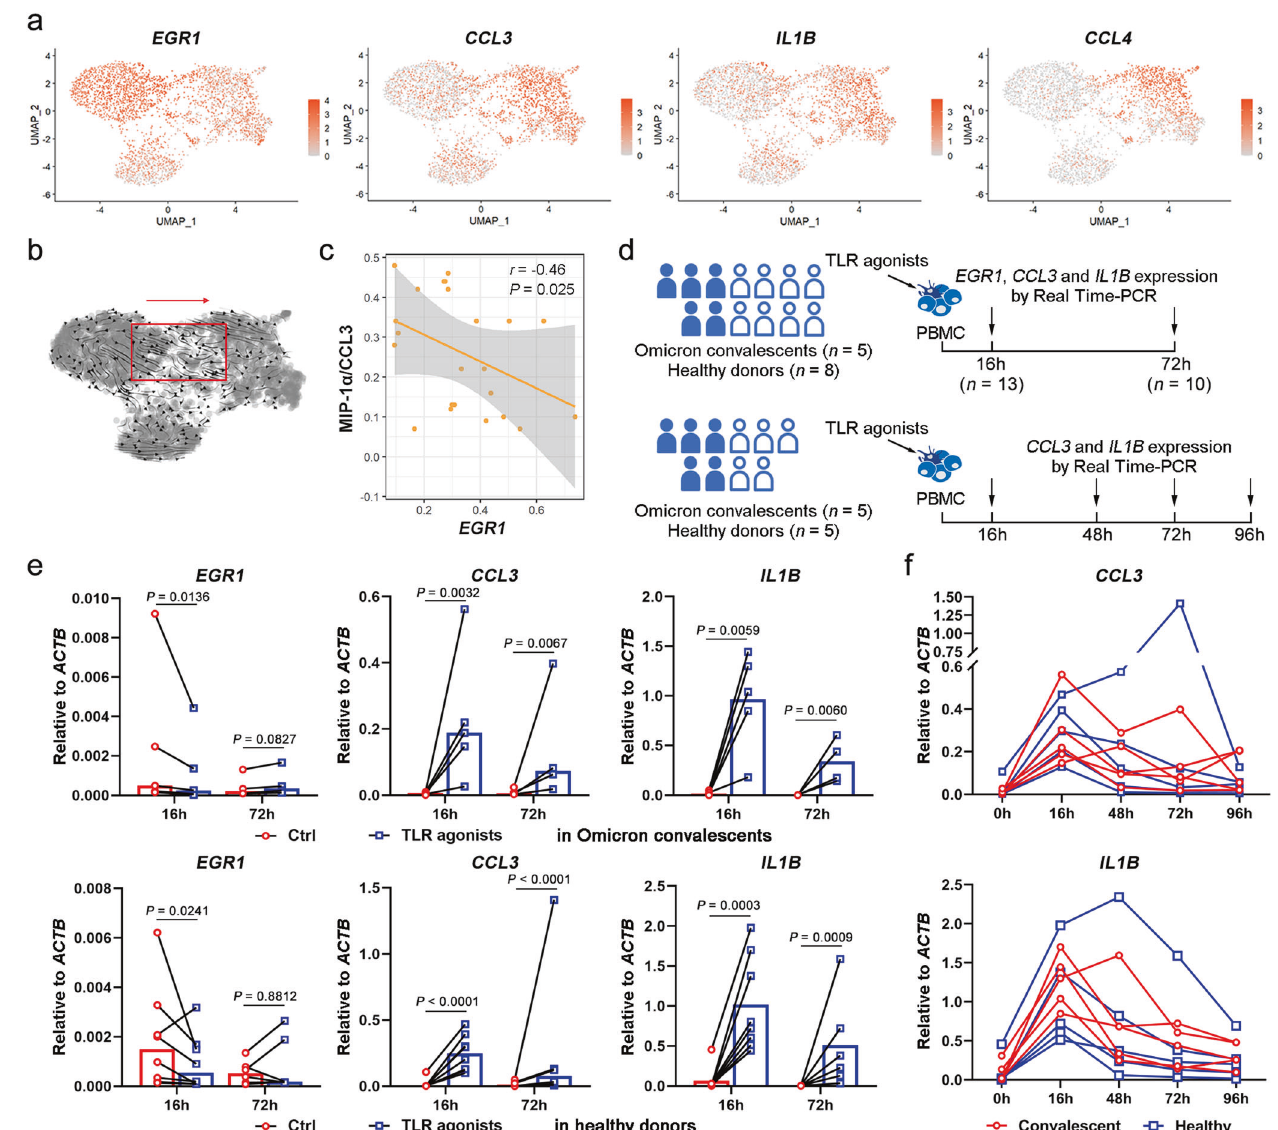
Fig. 5 The infection signal-polarized differentiation of EGR1 hi monocytes to CCL3 hi mature monocytes in Omicron convalescents. a UMAP plots showing the expression of CCL3 , EGR1 , IL1B and CCL4 in the EGR1 + monocytes by WTA scRNA-seq. b RNA velocity analysis of EGR1 + monocytes showing that EGR1 hi monocytes may differentiate to CCL3 hi monocytes. c Association between the EGR1 expression by TTA scRNA- seq and plasma levels of MIP-1 α /CCL3 in convalescents ( n = 7 for mild and n = 16 for moderate). d – f The TLR agonists-induced expression of EGR1 , CCL3 and IL1B in PBMCs of the Omicron convalescents and healthy donors. The experimental fl ow chart is shown in ( d ). PBMCs derived from Omicron convalescents and healthy donors were stimulated with LPS (100 ng/ml) plus PolyIC (25 ų g/ml) for indicated time and the expression of EGR1 , CCL3 and IL1B were determined by Real-time PCR assays. Relative expression to ACTB was shown. Samples at 16 h included fi ve convalescents and eight healthy donors, while at 72 h included four convalescents and six healthy donors due to limitations in the amount of PBMC isolated from samples. The relative expression of EGR1 , CCL3 and IL1B in PBMCs of the Omicron convalescents is shown in the upper panel of ( e ) and that of healthy donors is shown in the lower panel of ( e ). Ratio paired t -test. Samples from fi ve convalescents and fi ve healthy donors were used in dynamic curve and shown in ( f ) reduce the amounts of active IL-1 β from extracellular pro-IL-1 β with IL-1 β - or IFN- responsive signatures. Additionally, the cleaved by proteinase 3. 39 Single nucleotide polymorphisms emergence of massive CCL3 hi monocytes in circulation has been reported by many previous studies from severe COVID-19 patients (SNPs) in the PI3 gene or low PI3 plasma levels show an in the acute phase, 36,37 our fi nding that EGR1 hi monocytes can association with the increased risk of ARDS, 27,40 suggesting that transit to CCL3 hi monocytes implied the potential sources of CCL3 hi PI3 can play a protective role in controlling the progression of COVID-19. VNN2 hi monocytes may be another subset affecting the monocytes in severe COVID-19 patients. PI3 + LDNs and VNN2 hi monocytes might be critical for Omicron disease severity. VNN2 hi monocytes are monocytic myeloid- patients with only asymptomatic or mild symptoms. We identi fi ed derived suppressive cells that inhibit T cell responses, present in for the fi rst time a protective subset of LDNs with high expression healthy individuals as an immune-homeostasis compartment to of PI3 . PI3 is a serine proteinase inhibitor targeting proteinase 3 an appropriate immune response as well as massively increased in that participates in tissue injury. 38 PI3 has also been reported to some tumors for building an immune inhibitory milieu. 41,42 The Signal Transduction and Targeted Therapy (2022)